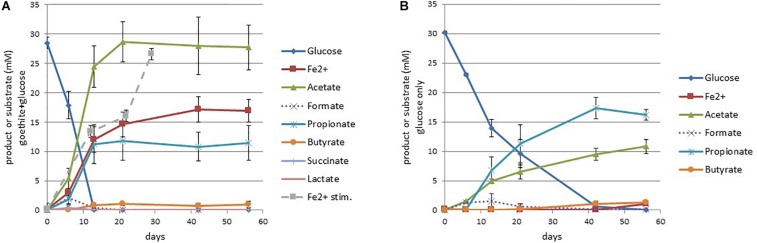
Short chain fatty acid and ferrous iron production with glucose consumption for cultures with (A) and without (B) goethite. The dashed line (Fe2+ stimulation in graph A) is measured ferrous iron when cultures were provided with more glucose (30 mM) at day 22. Error bars represent the standard error of the mean (n = 3).